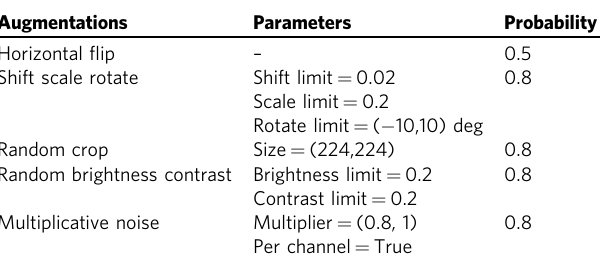
Table 1 Data augmentation parameters used in our